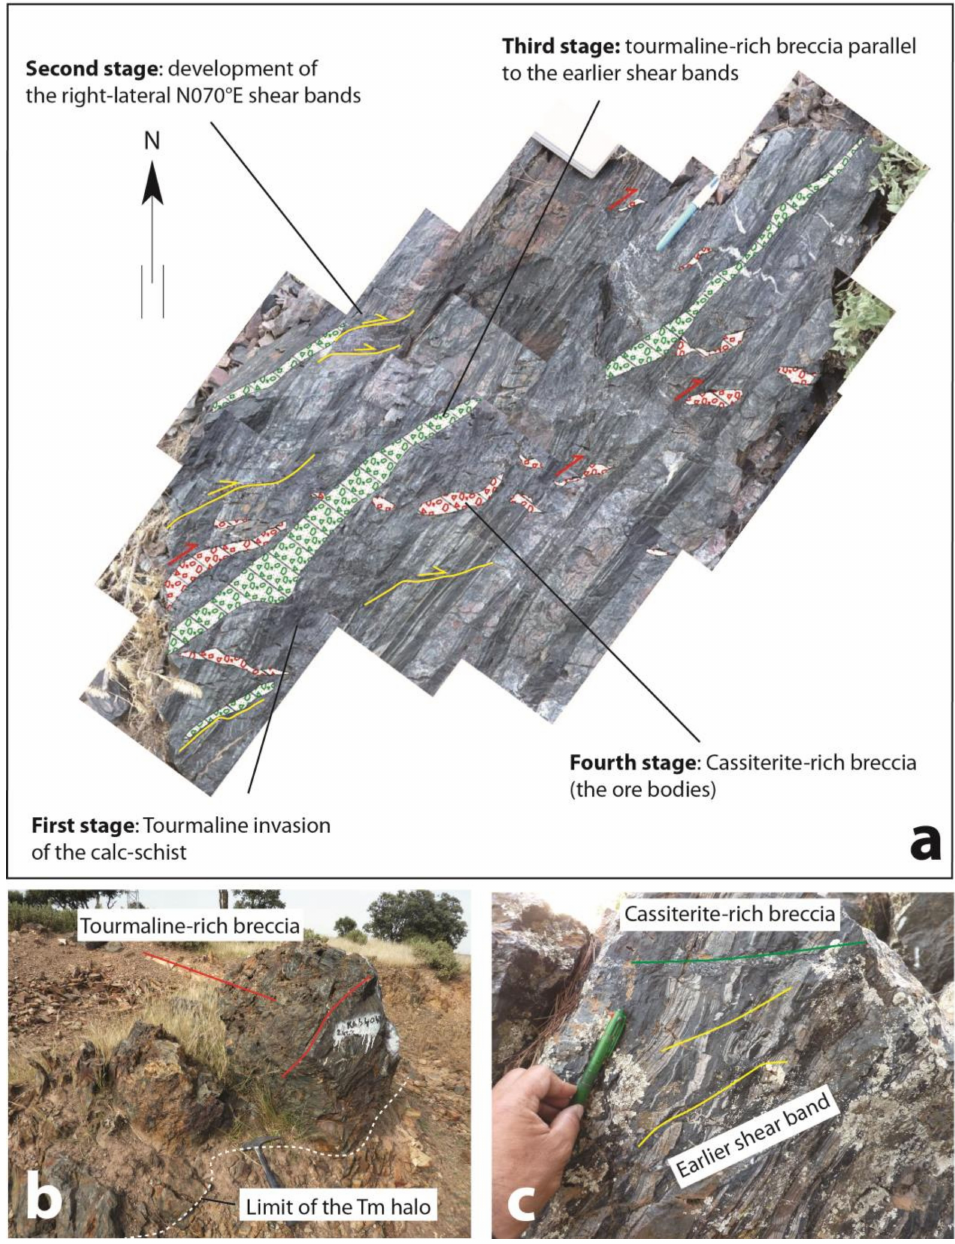
Figure 10. Deposit history and evolution of the four stages that explain the formation of the Achmmach tin deposit (Morocco) recognised in a unique block ( a ). ( b ) Image of the “North Zone” area in which the succession of structure can be observed. Note the limit of the tourmaline alteration halo that delimitate the zone where mineralisation developed. ( c ) Parallelism between ductile shear bands and mineralised breccia showing that breccia re-used the earlier plane of deformation to